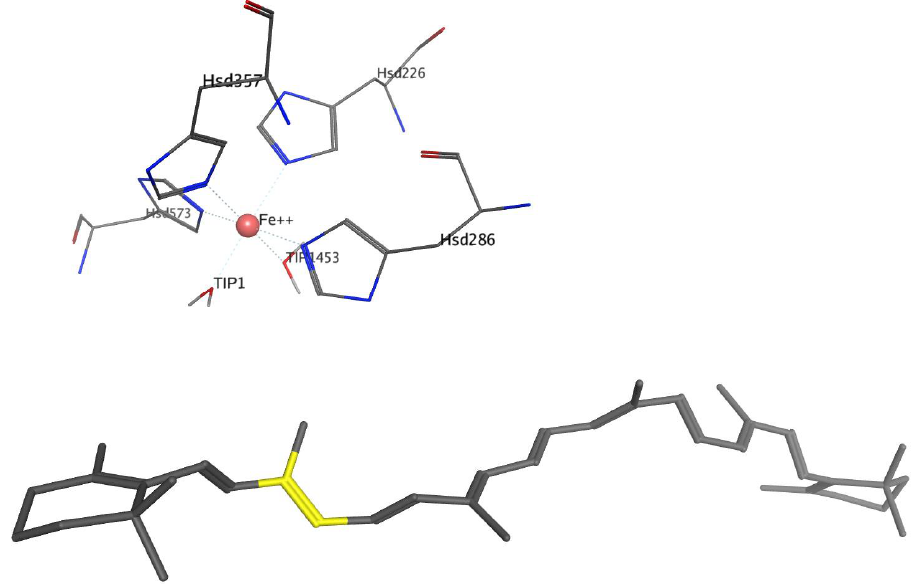
Figure 3. Rod representation of the active site of BCO2 and β-carotene. The Fe 2+ atom, represented by a pink sphere, coordinates with Hys226, Hys286, Hys357, Hys573 and two water molecules (TIP1, TIP1453), all represented by thin rods and colored according to atom type. The β-carotene is repre- sented by gray rods, and the 9–10 bond is in yellow. The average bond distances in Å between Fe 2+ and the histidine nitrogens are 2.09 ± 0.095, 2.09 ± 0.090, 2.07 ± 0.080 and 2.11 ± 0.094, respectively, and between Fe 2+ and the oxygens of the waters, 1.96 ± 0.071 and 1.95 ± 0.064,